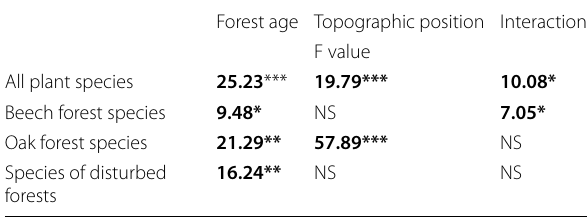
Table 5 Results of the generalized linear mixed-effects models for the number of species Forest age Topographic position Interaction